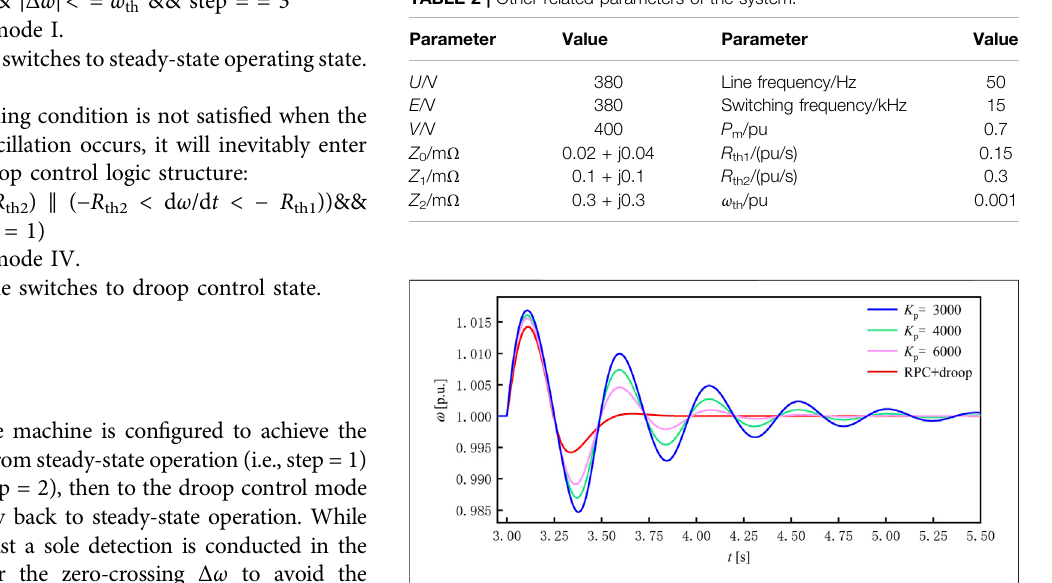
FIGURE 7 | Rotor speed dominated by droop control modes.